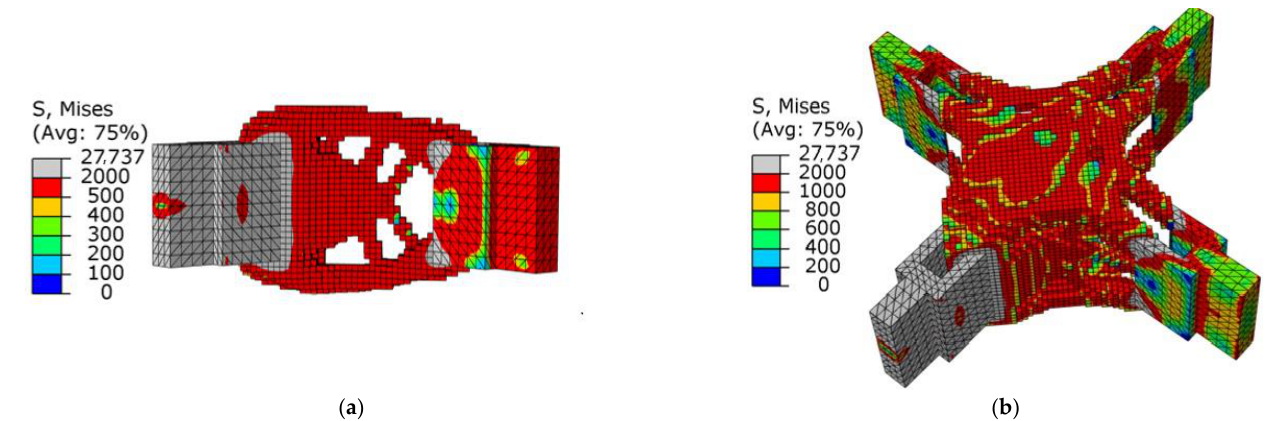
Figure 10. Schematic diagram of optimization results under shear conditions: ( a ) lateral view; ( b ) stress nephogram.